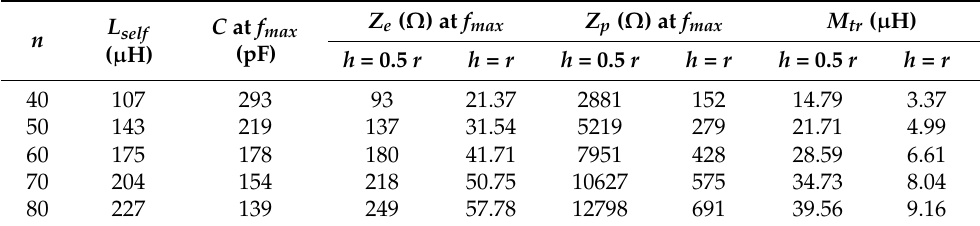
Table 5. Self and mutual inductances as well as compensating capacities and load impedance (at f max ) for circular coils and r = 25 mm.